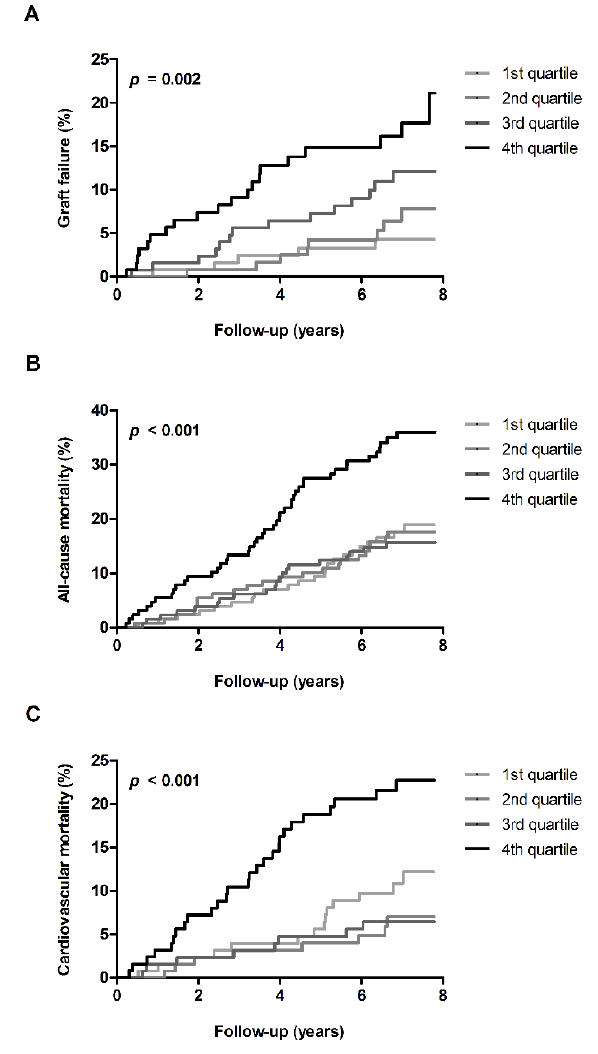
Figure 2. Kaplan–Meier curves of graft failure ( A ), all-cause mortality ( B ), and cardiovascular mortality ( C ) according to sex-stratified quartiles of plasma levels of group IIA secretory phospholipase A 2 (sPLA 2 -IIA).